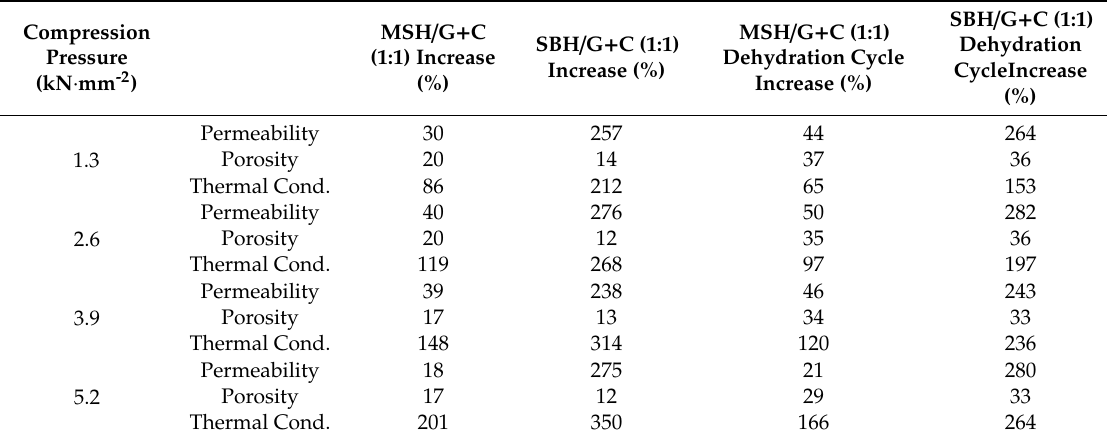
Table 3. Comparison of changes in the measured parameters of the